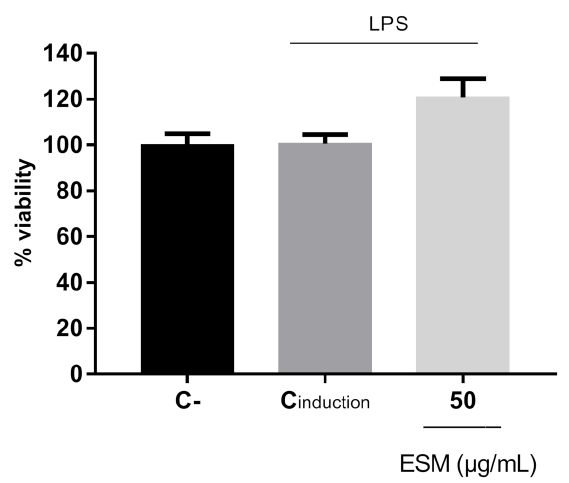
Figure 3. Effect of ESM 50 μg/mL on murine BV-2 cells microglial cells viability. Induction control (C DMEM with 2% FBS and LPS) and negative control (C- - DMEM with 2% FBS) were used. The test was performed in five independent experiments, each in triplicate. Results were expressed in inhibition percentage compared to the induction control. The mean ± S.E.M. of was